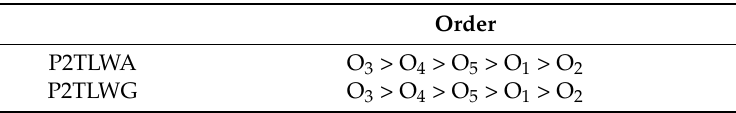
Table 7. Order of the green